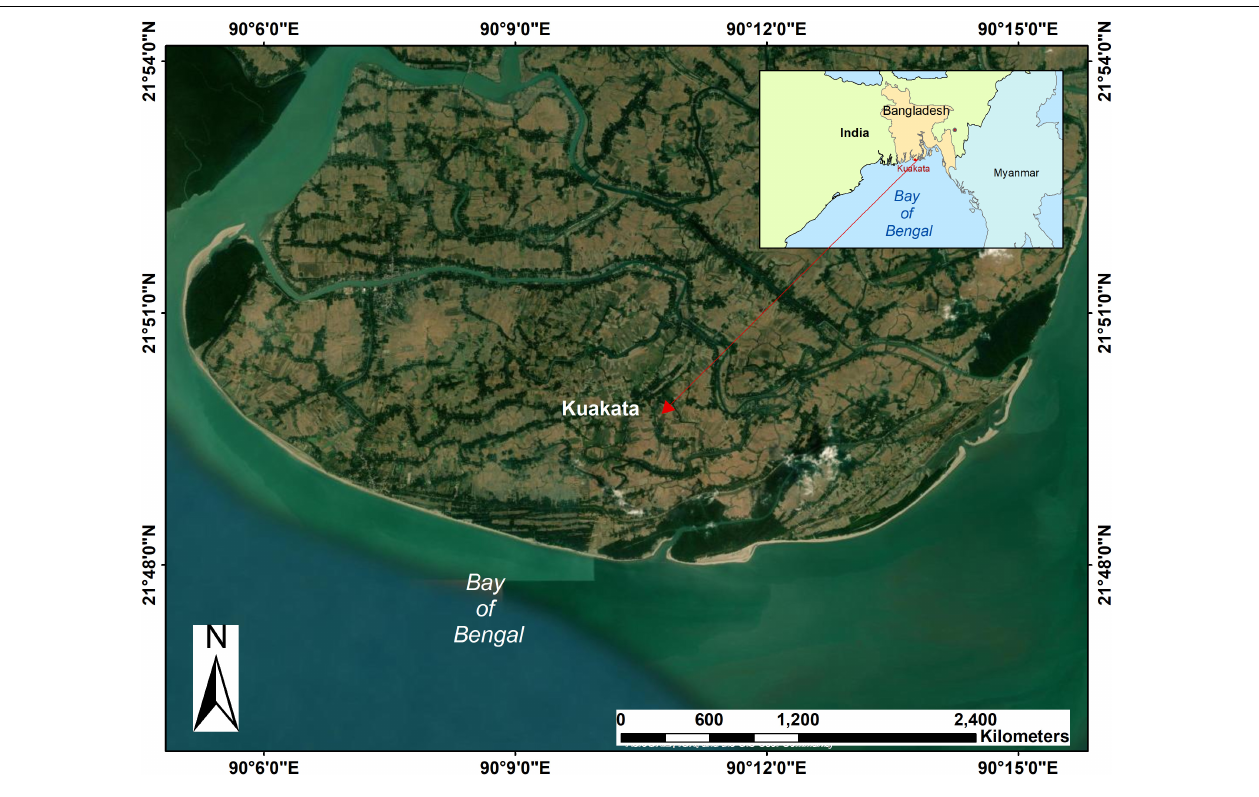
FIGURE 1 | Location of study